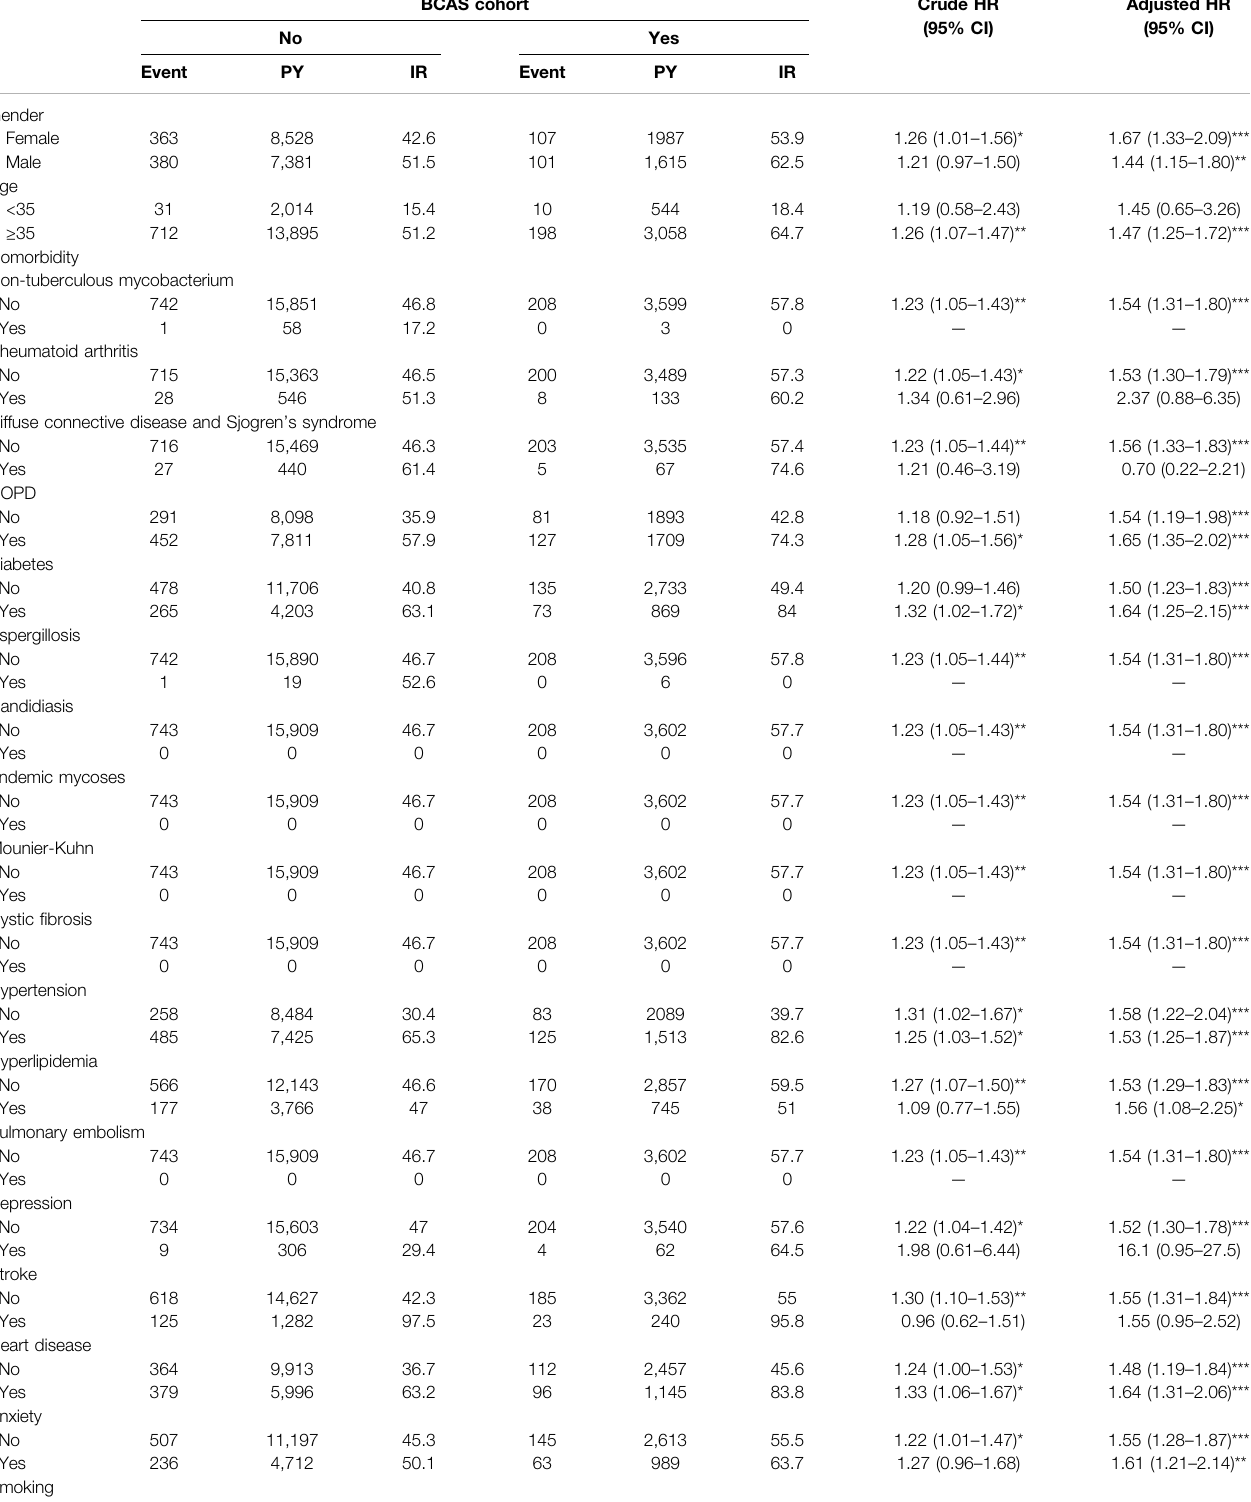
TABLE 3 | Incidence rate and hazard ratioof pulmonarytuberculosis or pneumonia between the two cohorts strati fi ed by gender, age, comorbidities, and medications after propensity matching. BCAS cohort Crude HR (95%